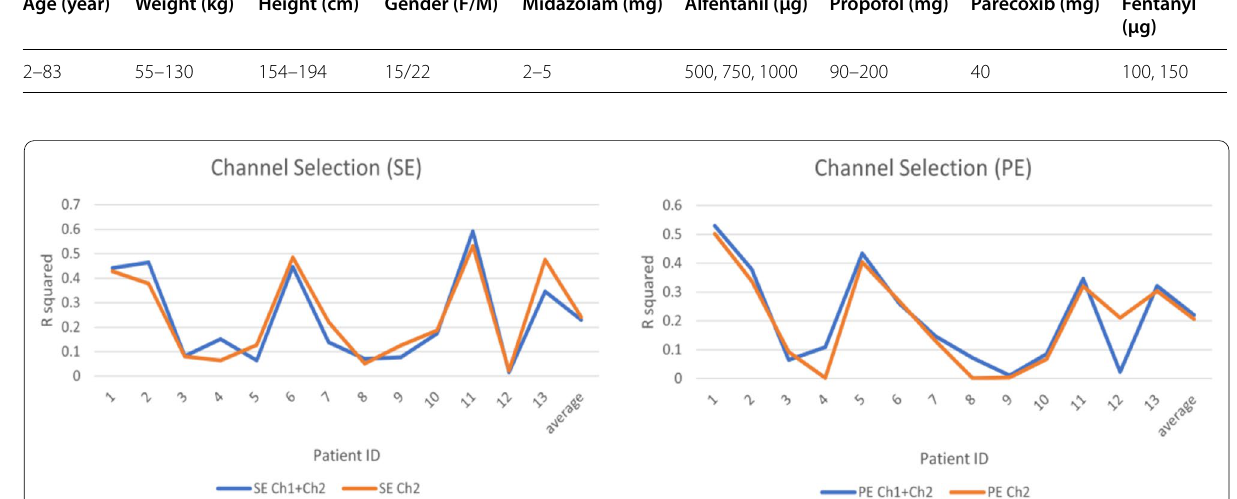
Ch2 EEG and Ch2 EEG (the reference is the BIS +